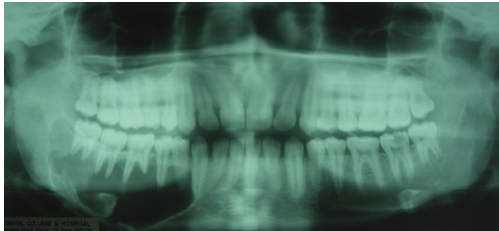
Figure 3: Panoramic radiograph showed a large well defined, sclerotic margined, multilocular radiolucent lesion with “soap bubble” appearance on right side mandible.